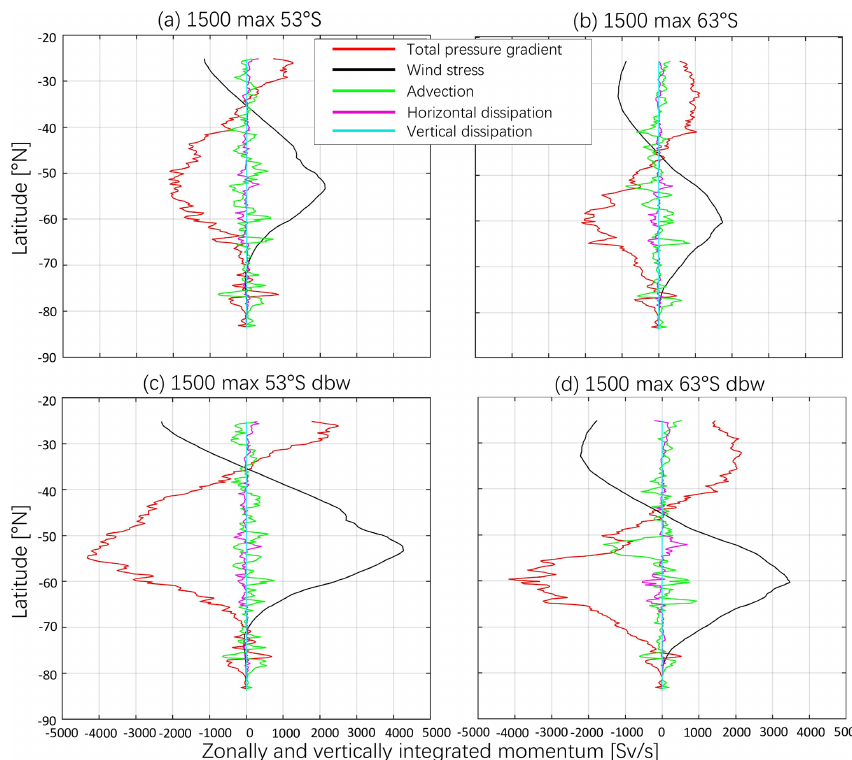
Figure A1. The vertically and zonally integrated zonal momentum budget: total pressure gradient (total form stress) (red; Svs − 1 ), wind stress (black; Svs − 1 ), advection (green; Svs − 1 ), horizontal dissipation (magenta; Svs − 1 ) and vertical dissipation (light blue; Svs − 1 ) in the 1500_max_53 ◦ S (a) , 1500_max_63 ◦ S (b) , 1500_max_53 ◦ S_dbw (c) and 1500_max_63 ◦ S_dbw (d)